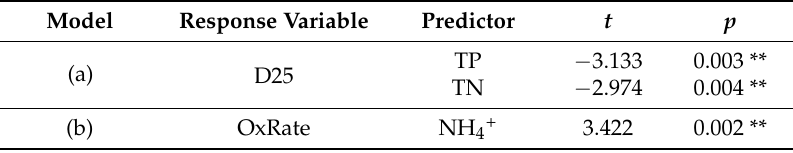
Table 3. Final General Linear Model and parameter estimates of ( a ) the response variable D25 and ( b ) the response variable OxRate. Number of tested data was 56 in each model and the months included ranged from February to